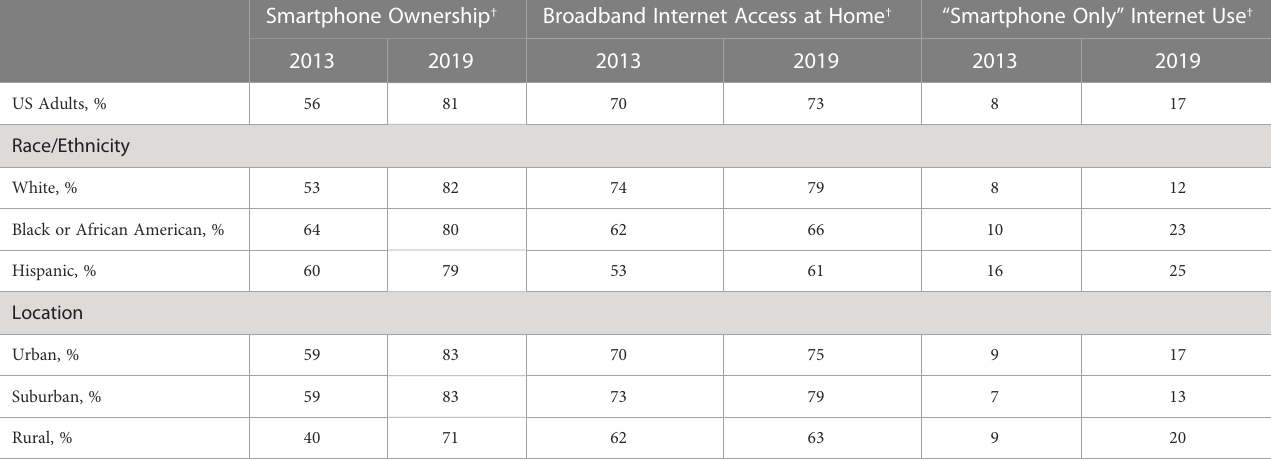
TABLE 2 Smartphone ownership and internet access patterns in the U.S. by race and ethnicity and by location,